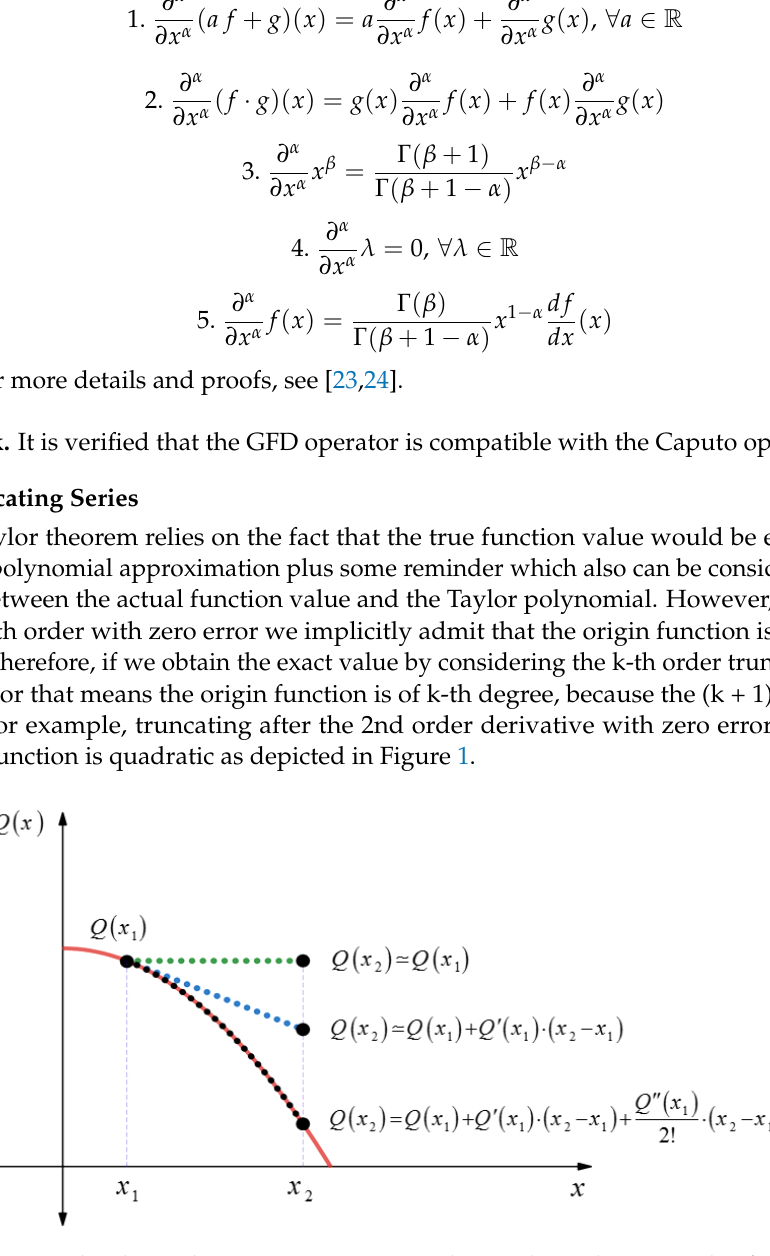
x to obtain the exact value for a quadratic 1